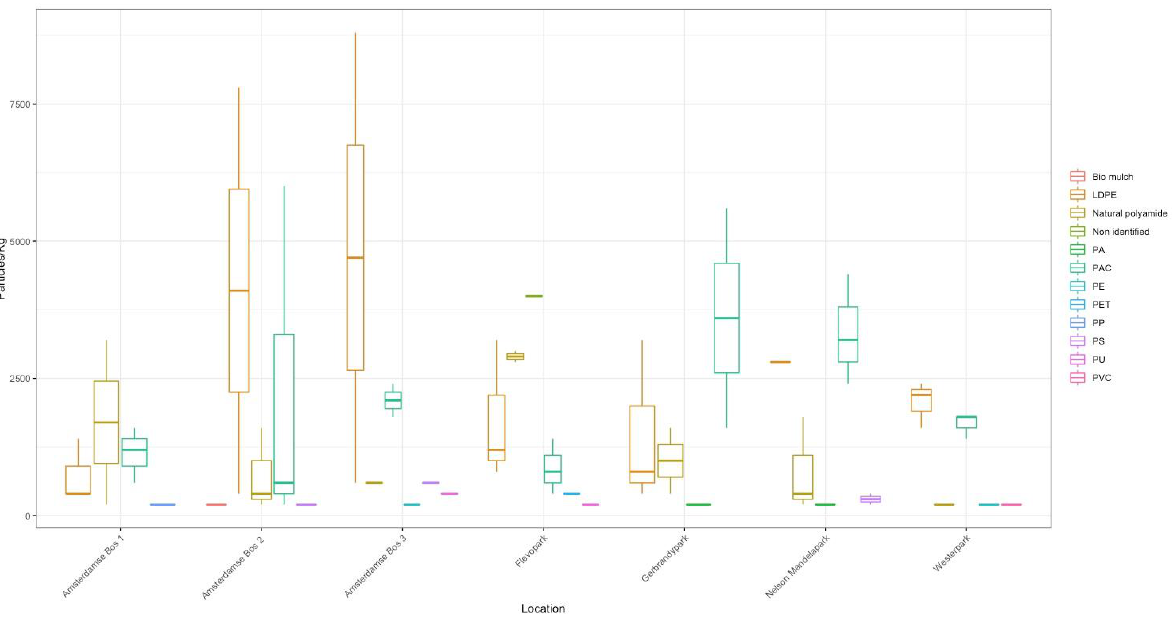
Figure 4. Plastic types in soils from parks and recreational areas that were analysed by city district in Amsterdam.